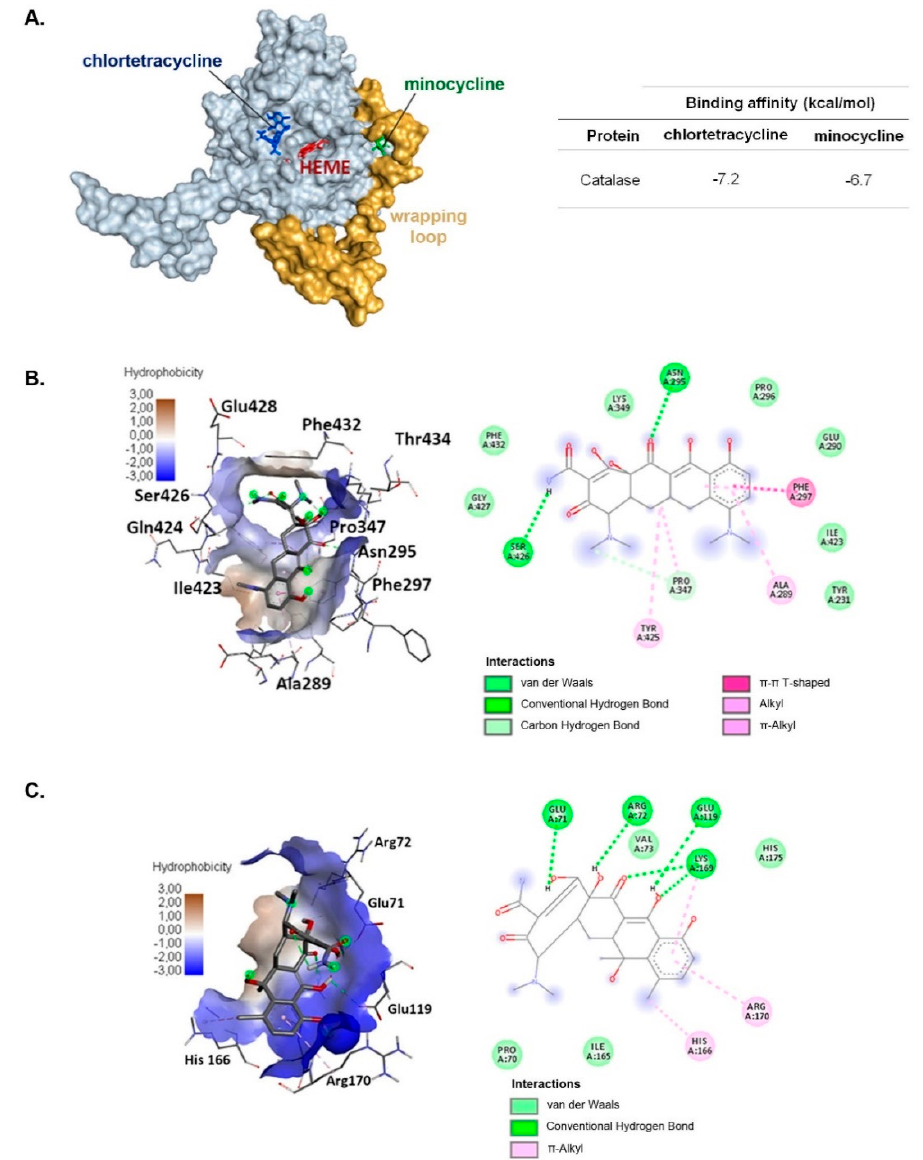
Figure 9. Molecular docking analysis of minocycline and chlortetracycline complexes with human catalase ( A ). The characteristic of interactions between minocycline ( B ) and chlortetracycline ( C ) and the responding binging sites within the enzyme.